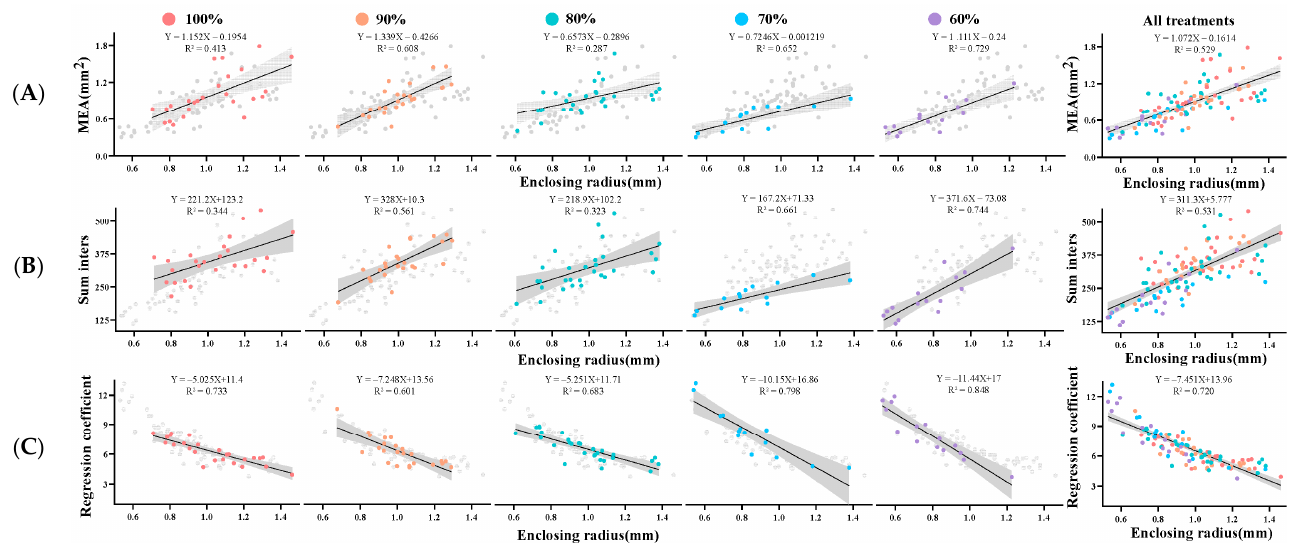
Figure 4. Regression analysis of mammary whole-mount results from maternally restricted offspring. Regression analysis between ( A ) mammary enclosing radius and mammary epithelial area (MEA), ( B ) mammary enclosing radius and sum inters and ( C ) mammary enclosing radius and Sholl regres- sion coefficient (k). The dots represent individual measured values, the black lines represent linear regressions, and the gray areas represent their 95% confidence